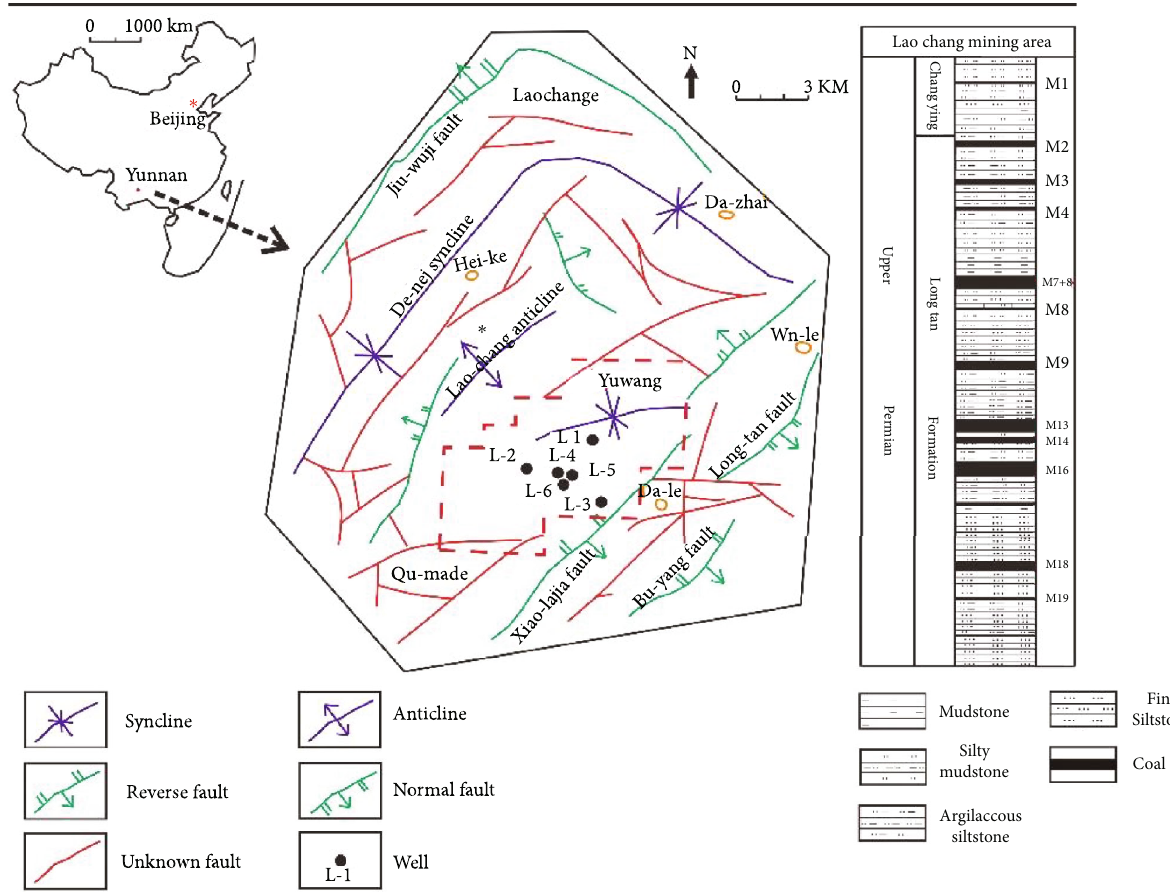
Figure 1: Study area structure and map of well